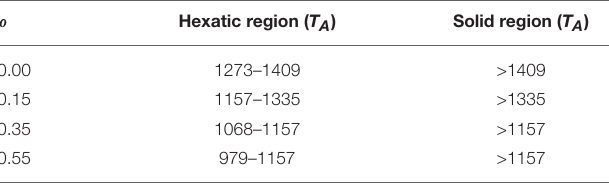
FIGURE 7 | The fraction, λ of each of the defect types considered as a function of T A for thermalized systems with parameters L of free disclinations marks the transition from liquid to hexatic phase, while the absence of free dislocations is indicative of the system having transitioned into the solid phase from the hexatic phase. The panels (A–F) correspond, respectively, to ρ are at least two orders of magnitude smaller than the ones drawn and we have omitted plotting them. TABLE 1 | Approximate phase regions in T A for each value of ρ extracted from the appearance/disappearance of topological defects (see Figure 7 ). ρ Hexatic region ( T A ) Solid region ( T A ) 0.00 1273–1409 >1409 0.15